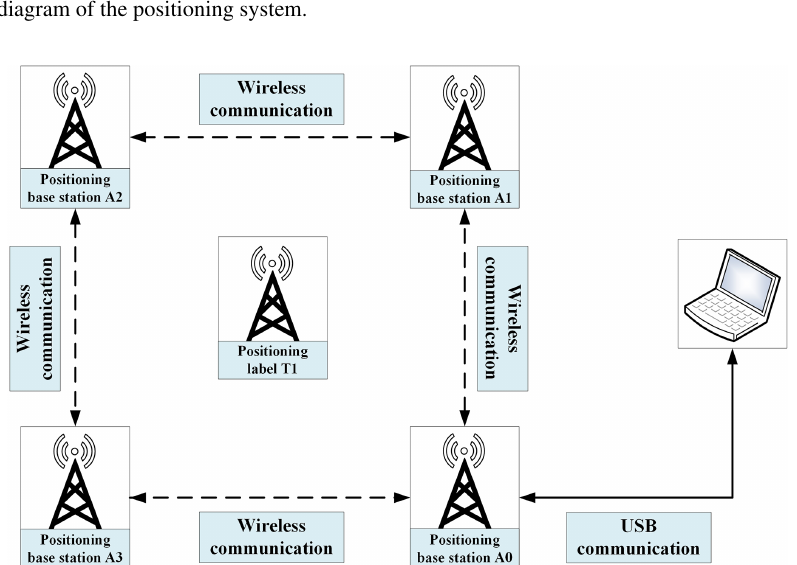
Figure 2. Hardware block diagram of the positioning system.